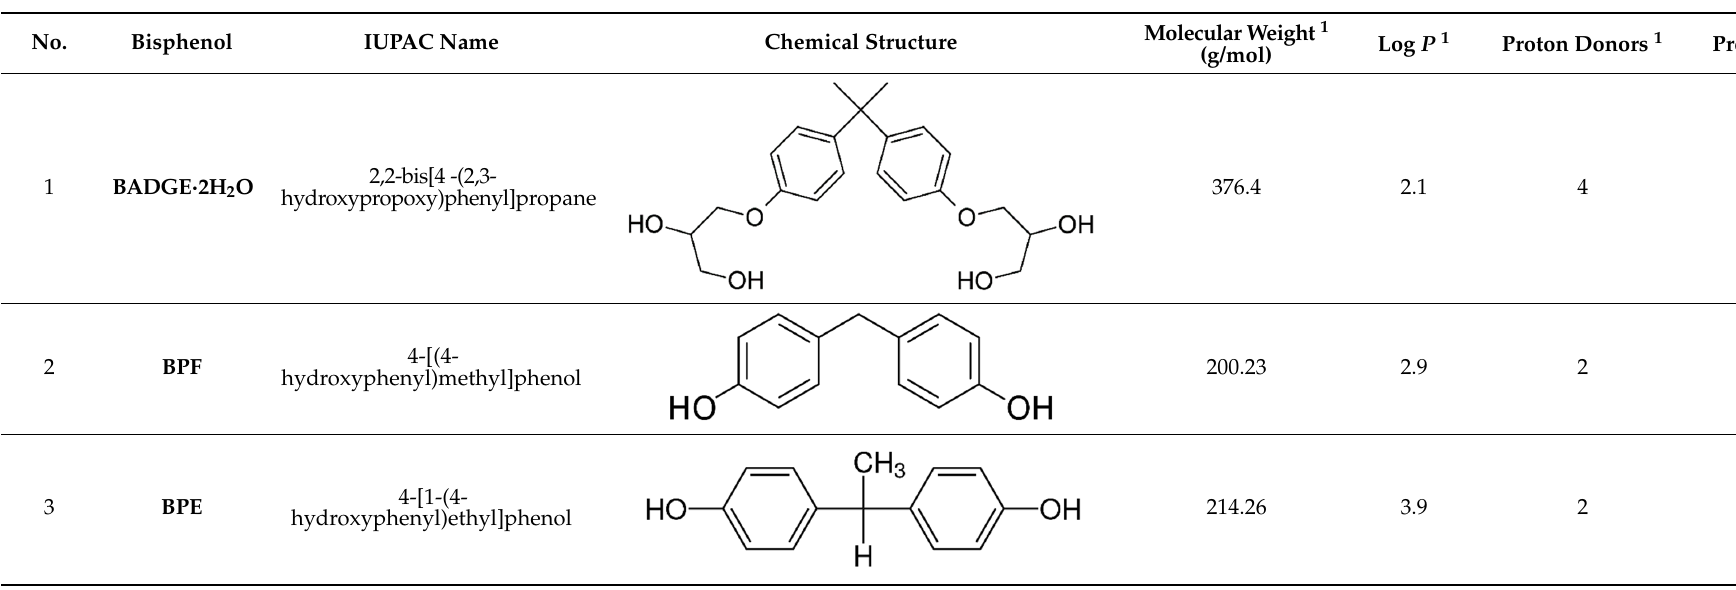
Table 2. Physicochemical properties of the selected bisphenols.